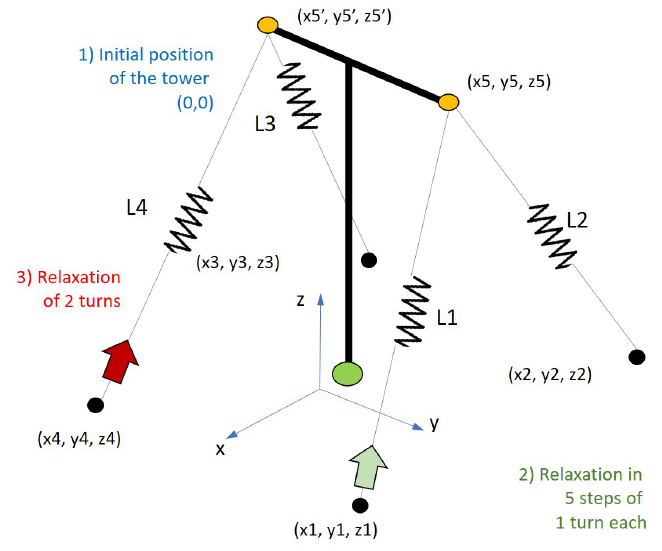
Figure 23. Case 1: Load cases applied to the tower in LabEDin , simulating the relaxation of two cables independently.